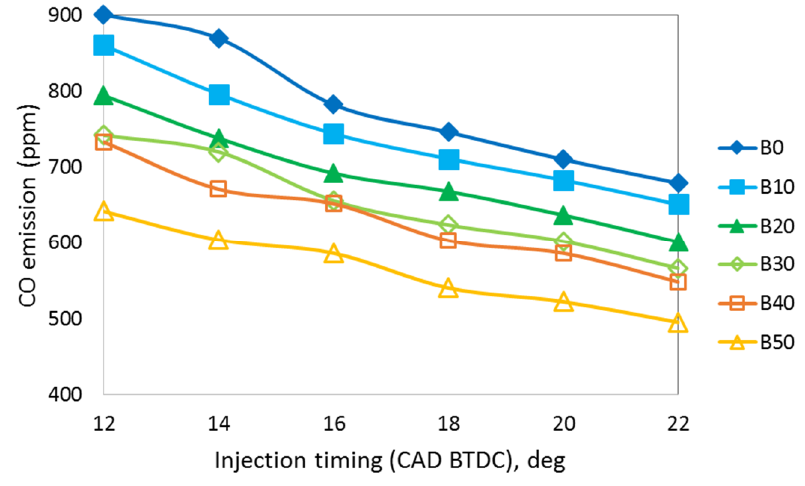
Figure 16. Effect of injection timing on engine CO emission.